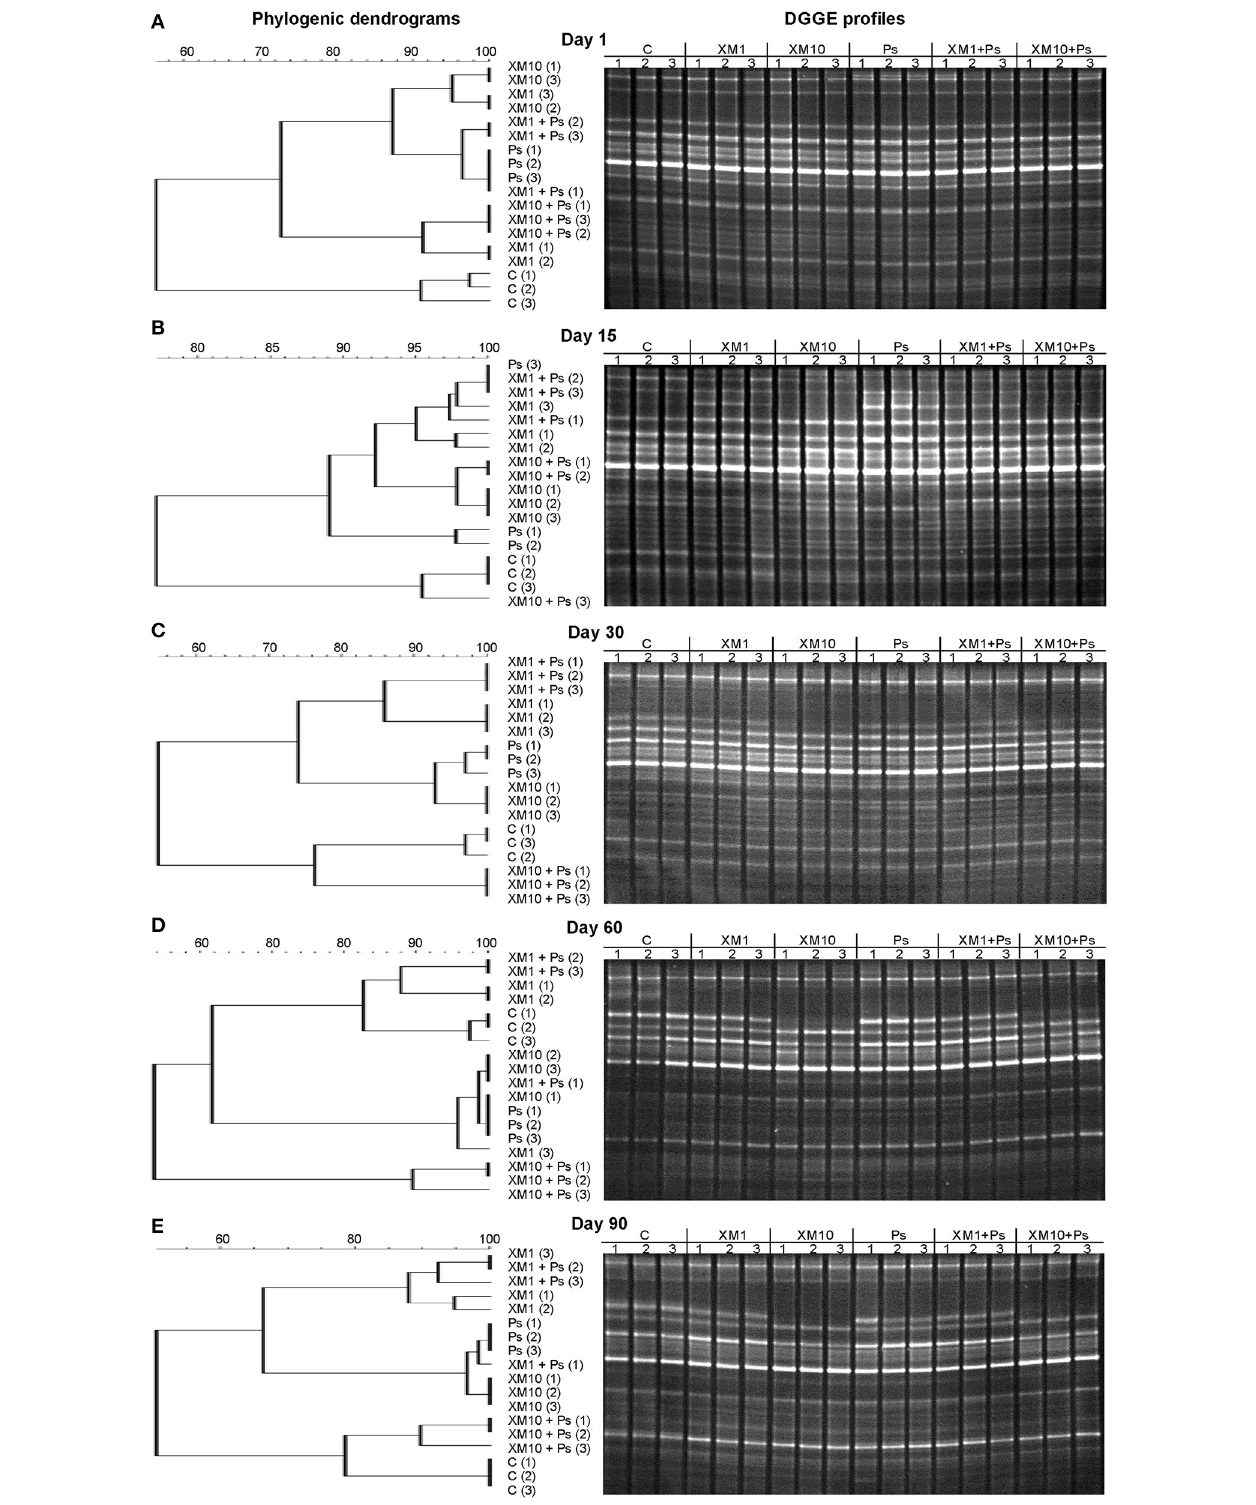
FIGURE 4 | Phylogenic dendrograms based on the DGGE profiles for the soil treated with cefuroxime and/or strain MC1 on days 1 (A) , 15 (B) , 30 (C) , 60 (D) , and 90 (E) . C, non-exposed soil; XM1, cefuroxime at 1 mg/kg soil; XM10, cefuroxime at 10 mg/kg soil; Ps, P . putida MC1; XM1 + Ps, cefuroxime at 1 mg/kg soil + P . putida MC1; XM10 + Ps, cefuroxime at 10 mg/kg soil + P . putida MC1.